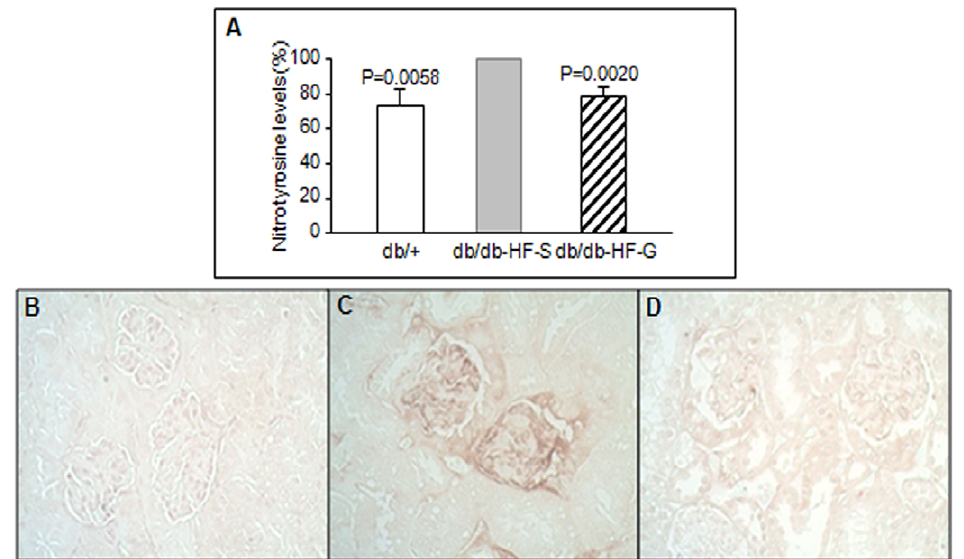
Figure 5. Effect of 17-DMAG on nitrotyrosine levels in the kidney. (A) Western blot analysis of nitrotyrosine was performed with monoclonal antibodies in kidney homogenates. The bar graphs were mean 6 SE density values from proteins # 50 kDa normalized to the db/db-HF-S group from 6 animals per group. The nitrotyrosine level in kidney sections of db/ + (C), db/db-HF-S (D) and db/db-HF-G (E) groups was assessed by immunohistochemistry with same monoclonal antibodies.